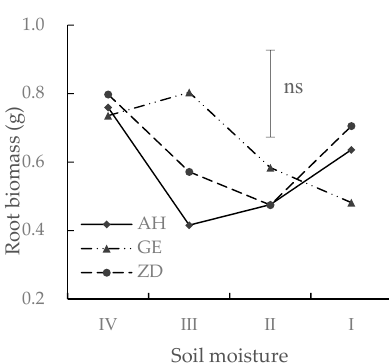
Figure 2. Interaction on root biomass between cultivars (Aohan (AH), Golden empress (GE) and Zhaodong (ZD)) and soil moisture (I: 75%–80% water holding capacity, II: 60%–65% followed by rehydration